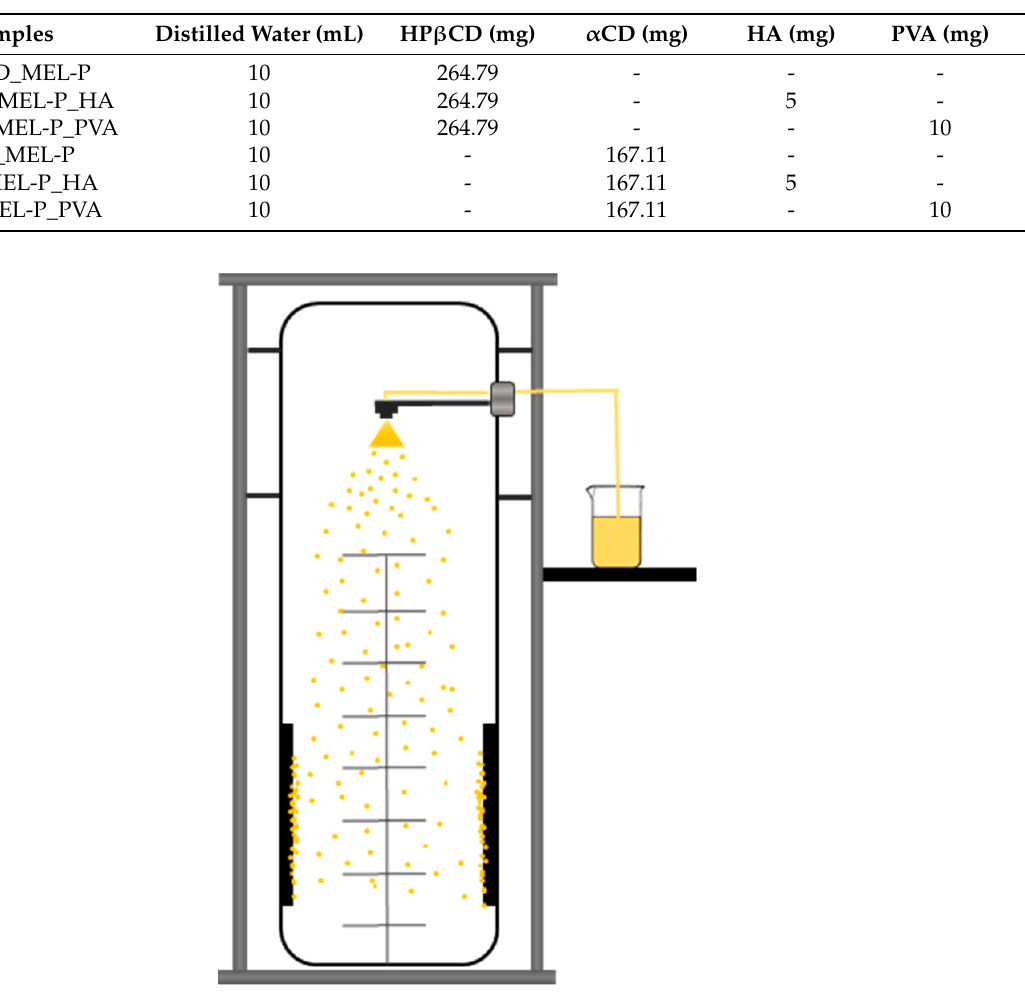
Table 1. Composition of the samples.